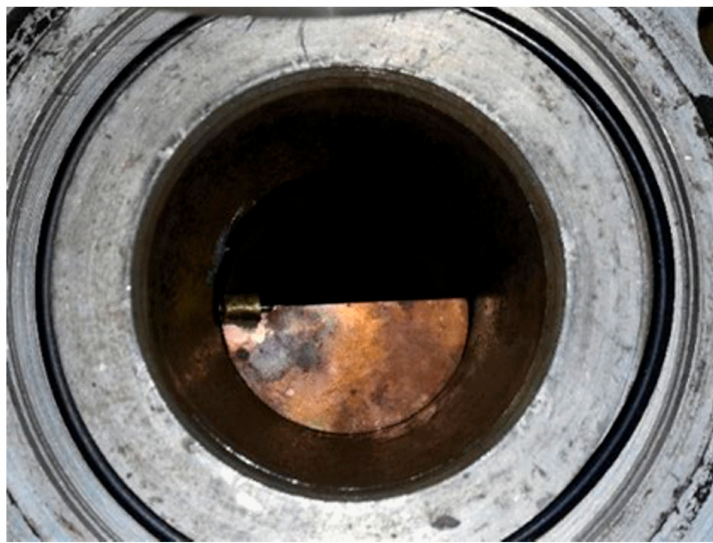
Figure 10. The obstacle placed in the duct.